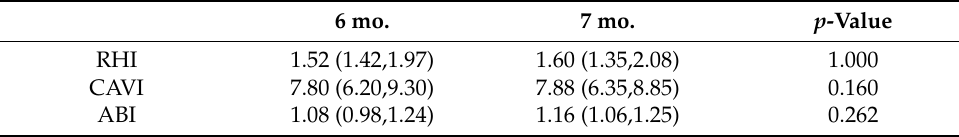
Table 7. Changes in arteriosclerosis index at six and seven months ( n = 10).